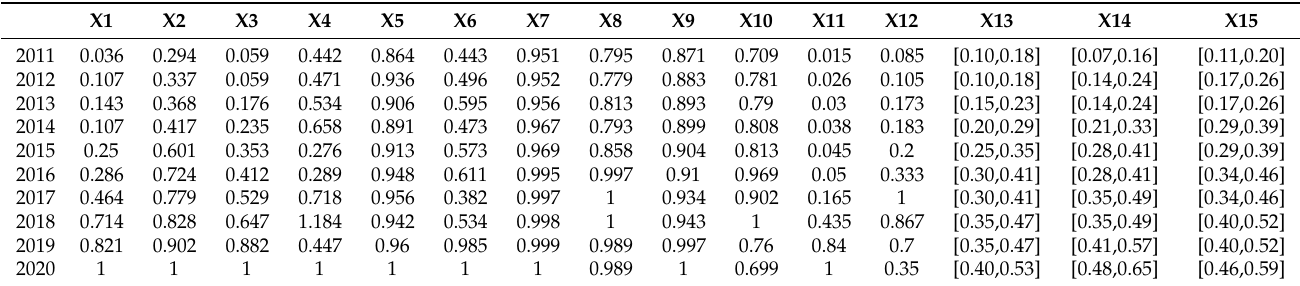
Table 6. Normalized decision